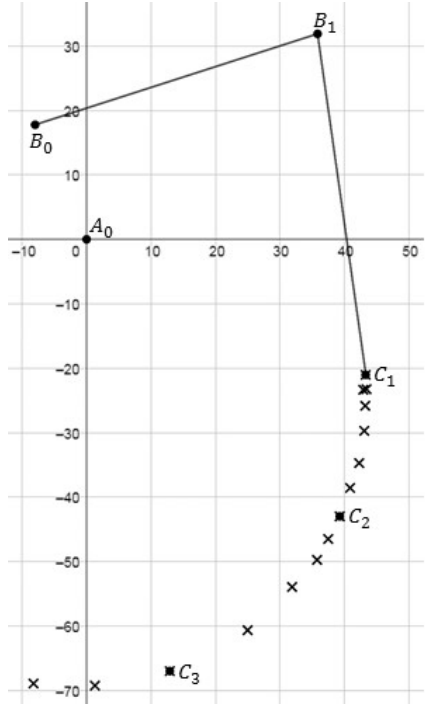
Figure 11. Initial problem of the synthesis for the second linkage with the selected three points C1, C2, C3 along the desired motion trajectory of point C.